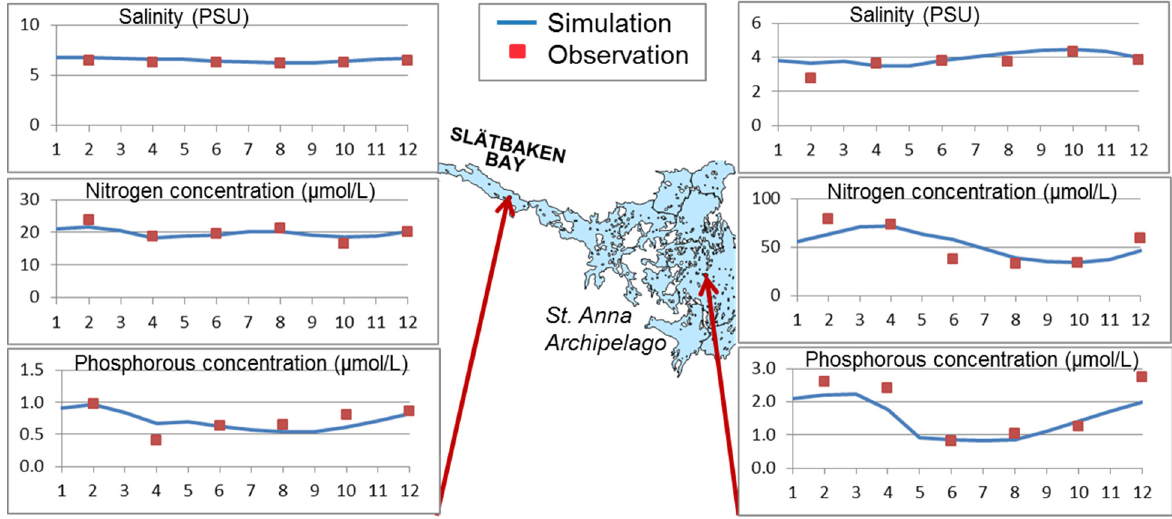
Figure 5. Daily averages of CZM simulations vs. bi-monthly observations of salinity, total N and P concentrations in the surface layer for Slätbaken Bay and Kärrfjärden (1–12 in x -axis indicates the months January to